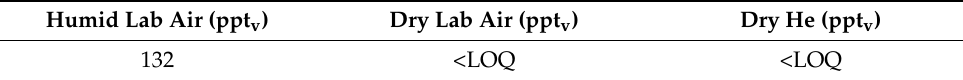
Table 10. Comparison of EtO blanks using different fill gasses. Average of 3 samples.